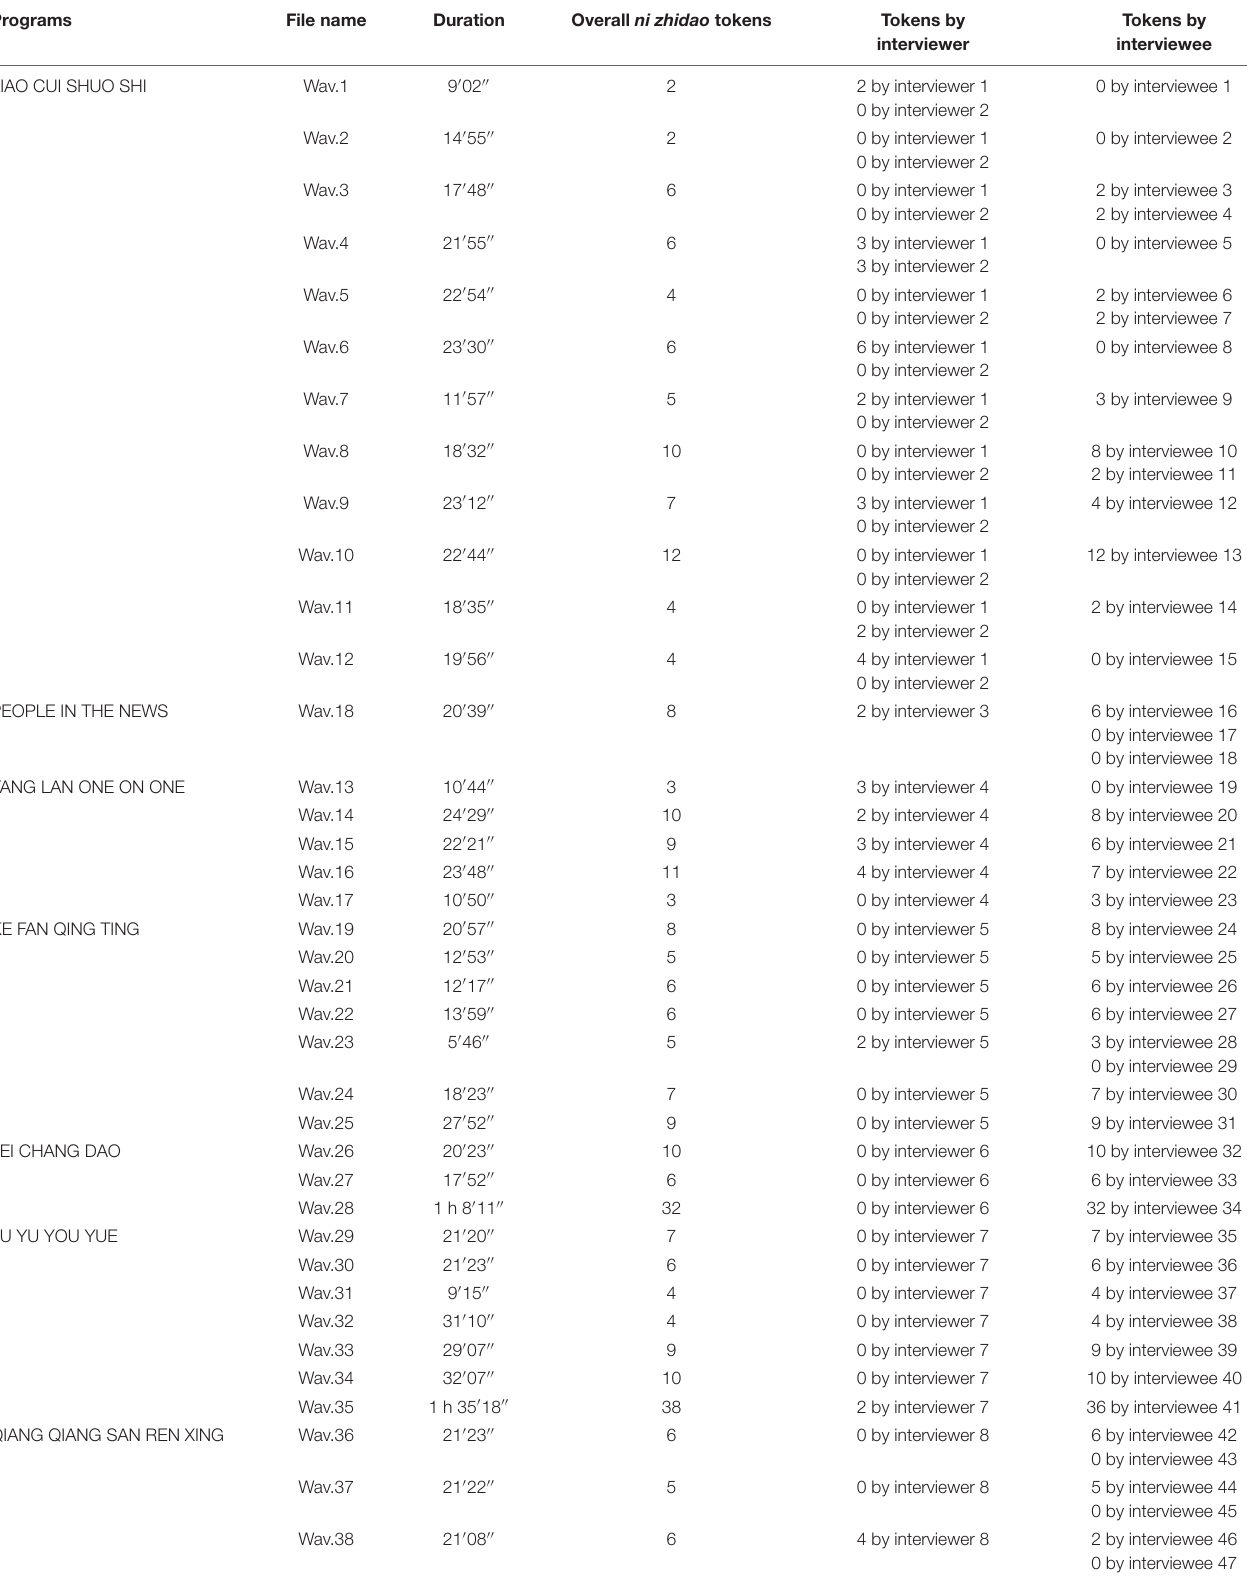
TABLE 2 | Profile of the audio data of 71 interview